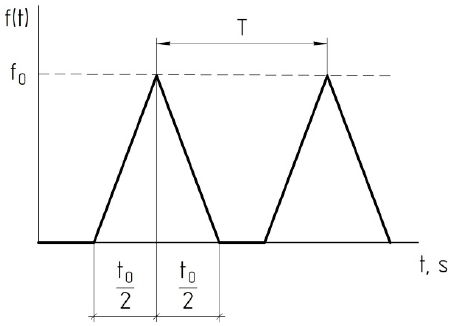
Figure 5. Triangular modulation function of the rotor pneumatic system.